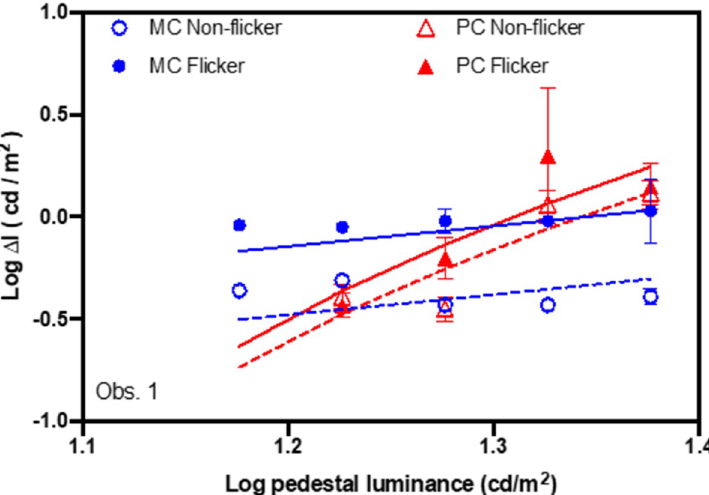
Fig 2. An observer’s steady- and pulsed-pedestal threshold data and model fits: (1) steady-pedestal paradigm (MC pathway) non-flicker adaptation condition (open circle); (2) steady-pedestal paradigm (MC pathway) flicker adaptation condition (filled circle); (3) pulsed-pedestal paradigm (PC pathway) non-flicker adaptation condition (open triangle); (4) pulsed-pedestal paradigm (PC pathway) flicker adaptation condition (filled triangle). Lines are the model fits from Eqs (1) and (2).